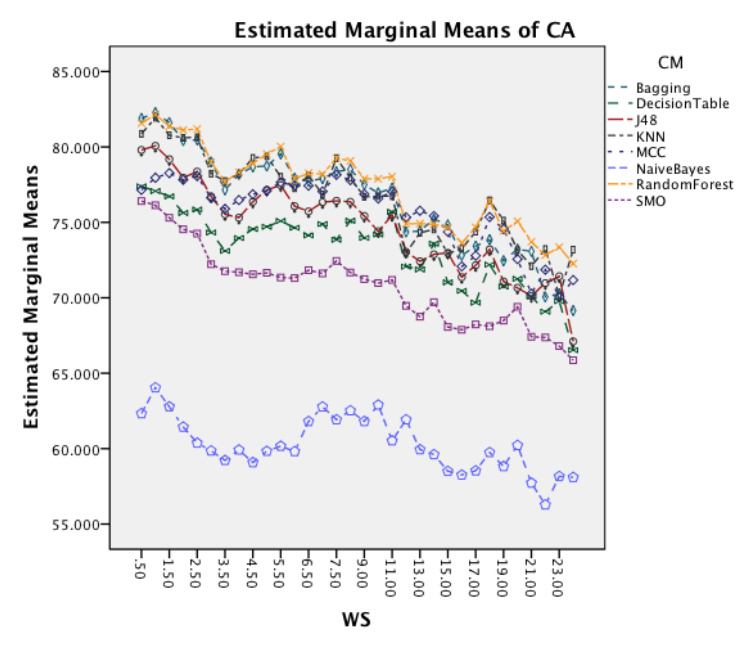
Figure 11. Two-way interaction effect for WS and